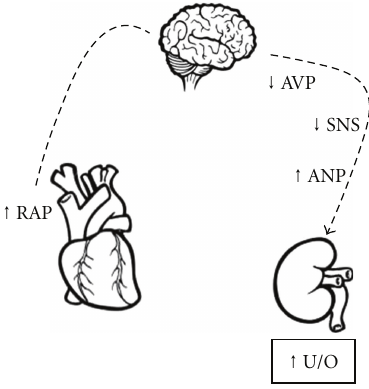
Figure 1: Physiologic interaction of neurohormones and main- tenance of total blood volume. U/O: Urine output, ↑ : increased, RAP: right atrial pressure, ANP: atrial natriuretic peptide, SNS: sympathetic nervous system and AVP: arginine